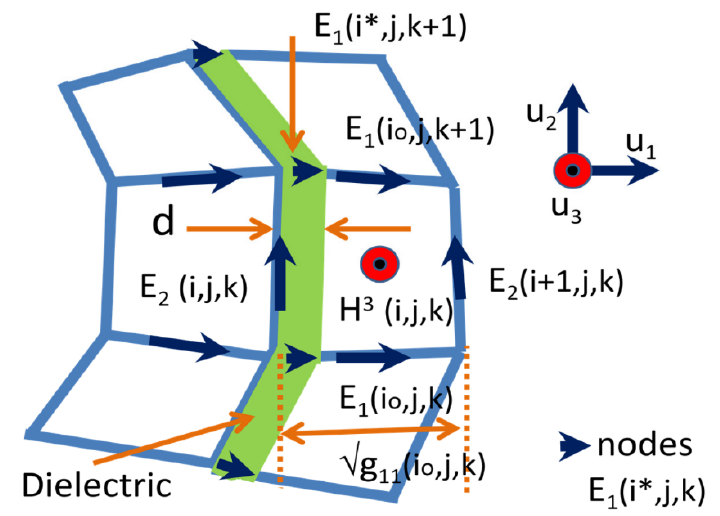
Figure 2. Special subgrid model of a thin dielectric slab. Index (*) for special nodes. The thin material slab has conductivity σ , dielectric constant ε , and permeability µ = µ 0 . The above FDTD procedure is used for all the cells with exception of the special cells where the thin slab is located. In these special cells, the electric field normal to the slab, E 1 , is split in sub-components E 1 ( i* , j , k ) and E 1 ( i 0 , j , k ), to take in account the discontinuity in the dielectric. The i 0 , accounts for the line u 1 = constant , where the thin slab is located, and i* is the index of the new field node located at the position of the thin slab. The other field components do not need to be split because they are tangential to the slab and are continuous functions. The update equations for E 1 ( i 0 , j , k ) involve H 3 and H 2 that are outside the dielectric. The E 1 ( i* , j , k ), located in the special nodes of the dielectric are updated using the same magnetic field components as E 1 ( i 0 , j , k ), because the H 3 and H 2 components are continuous across the dielectric. However, the closed path of Ampere’s law used in the updating of E 1 ( i* , j , k ) is inside the dielectric. Therefore, when calculating E 1 ( i* , j , k ), dielectric constant changes and losses are considered,